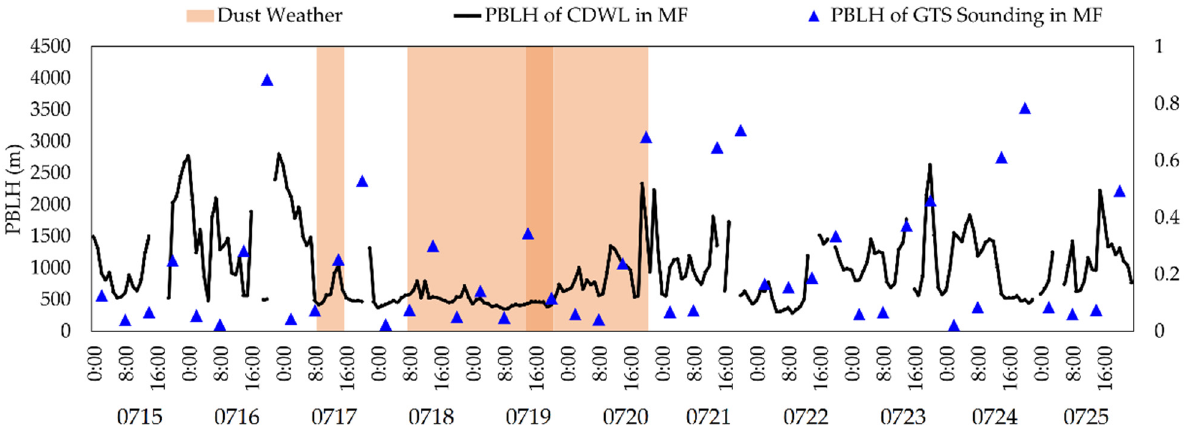
Figure 9. PBLH of dusty weather processes and before and after soundings and the CDWL inversions at the MF station.